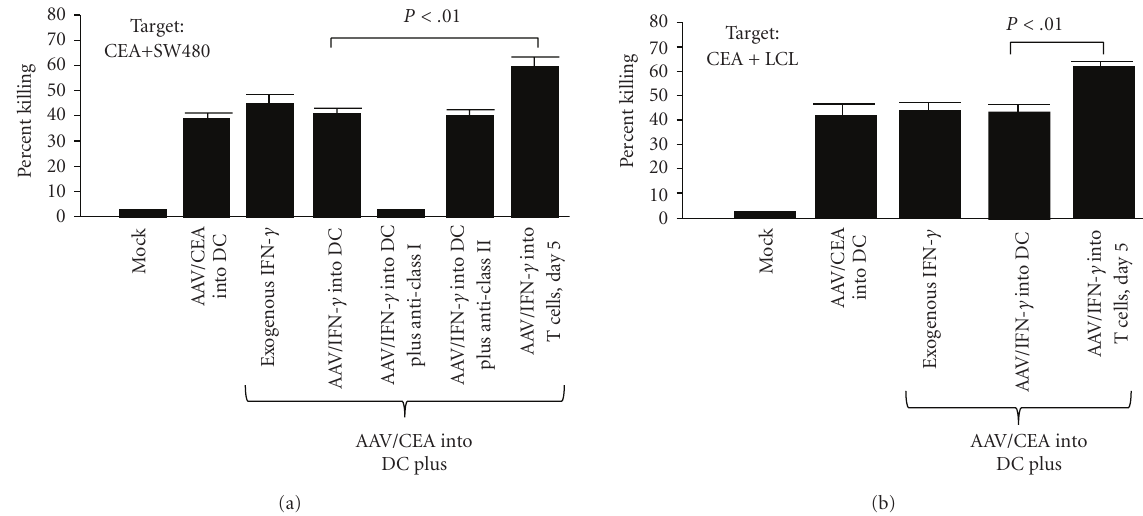
Figure 8: Enhanced CTL killing by IFN- γ autocrine delivery. (a) shows CTL killing after the indicated treatment, of CEA-positive targets, SW480 cells, by standard 51 Cr release assay. All assays were done at a e ff ector: target ratio of 20 :1. Note that AAV/IFN- γ autocrine delivery resulted in CTL with the highest killing ability. (b) shows a similar CTL killing assay using CEA+ LCL cells as the target. Note that, again, AAV/IFN- γ autocrine delivery resulted in CTL with the highest killing